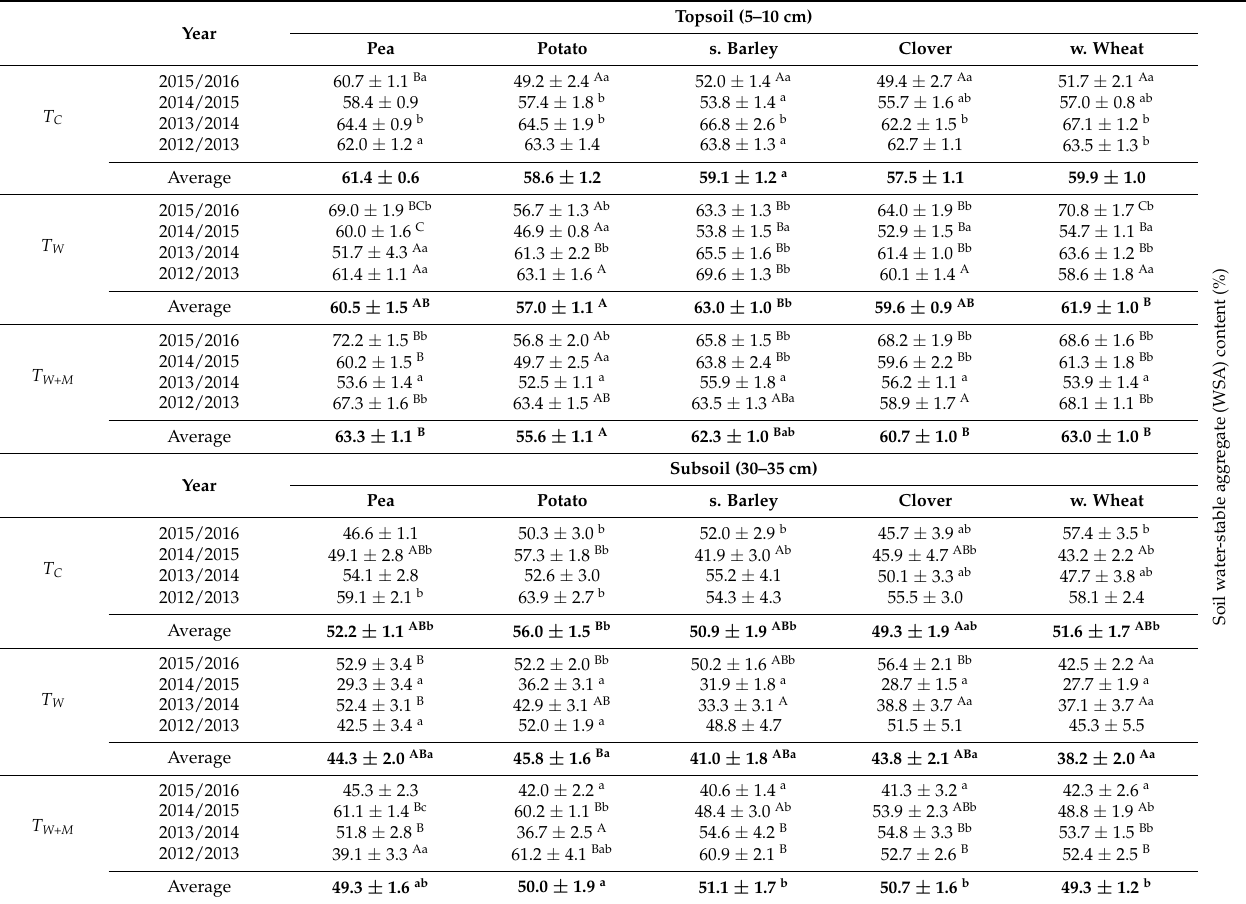
Table 4. The average content of soil water-stable aggregates (%) with the standard error (SE) of mean in the topsoil (5–10 cm) and subsoil (30–35 cm) by crops, winter cover crop management systems and